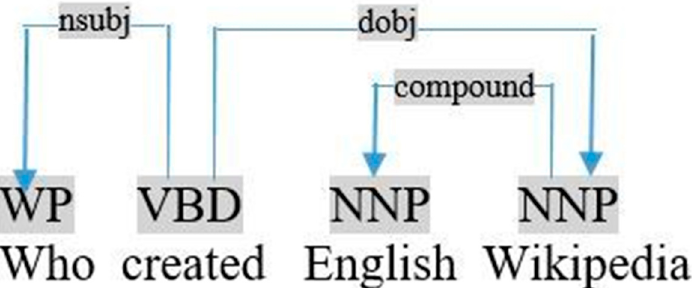
Figure 9. Graph dependency of the query «who created English Wikipedia».